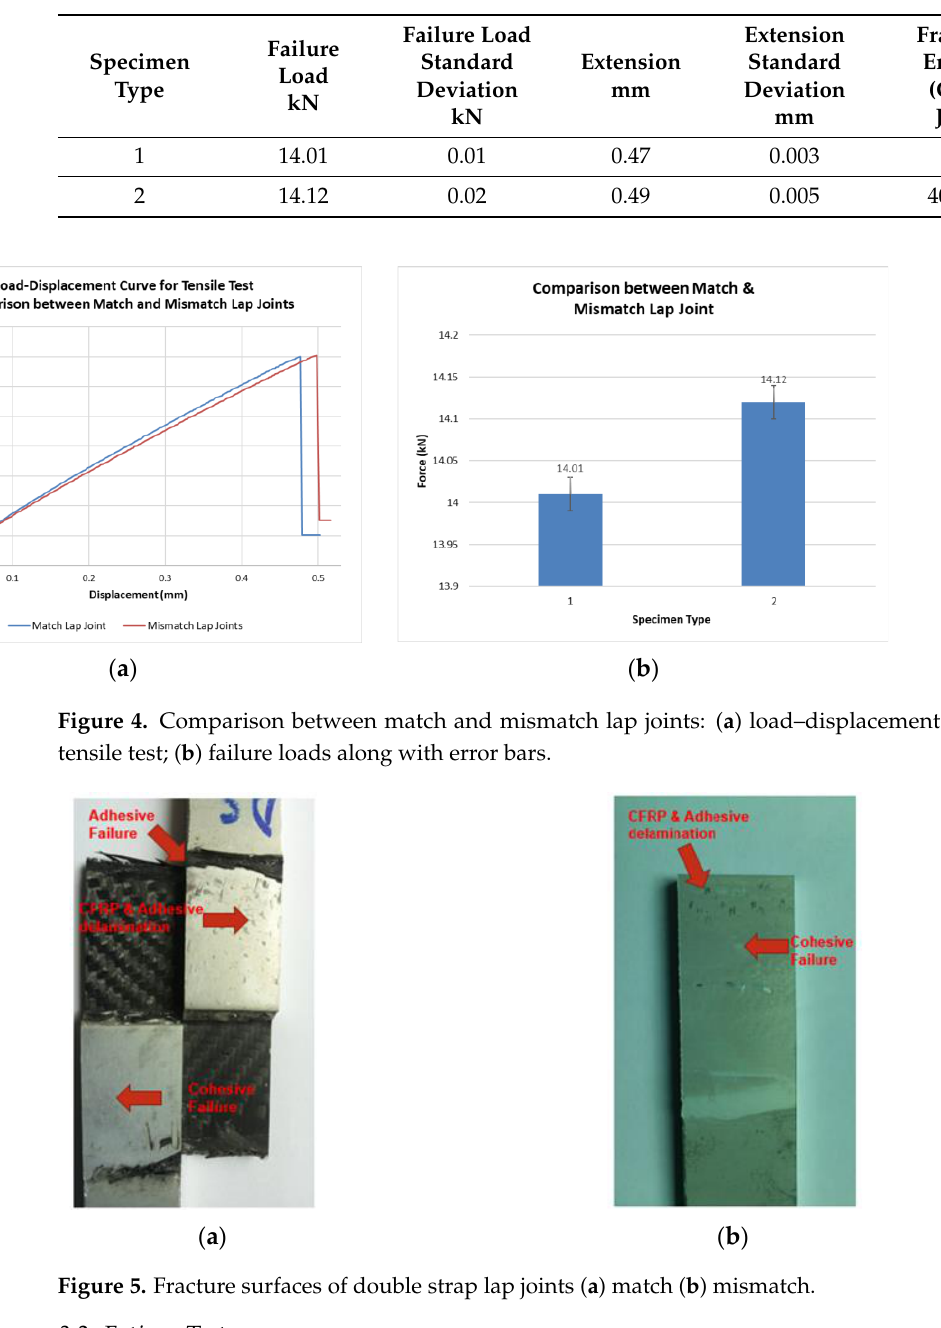
Table 3. Summary of the tensile test results.